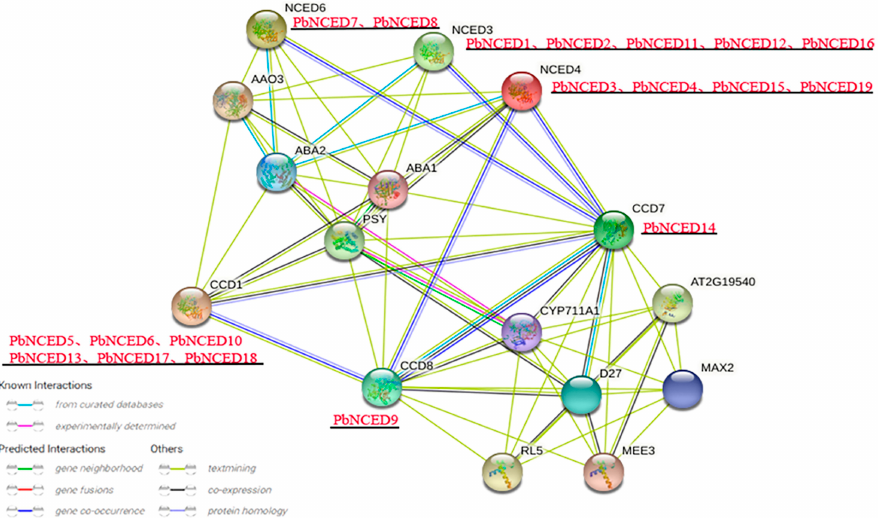
6 of 16 Figure 4. ( A ) Synteny analysis of PbNCED genes. Gray lines indicate all synteny blocks in the pear genome, whereas segmental duplicated homologous genes are indicated with red lines. ( B ) Synteny analysis of NCED genes between Arabidopsis , pear, and apple. The gray lines in the background indicate the collinear blocks with in pear and other plant genomes, while the blue lines highlight the syntenic NCED gene pairs. The chromosome number is shown at the top of every chromosome.